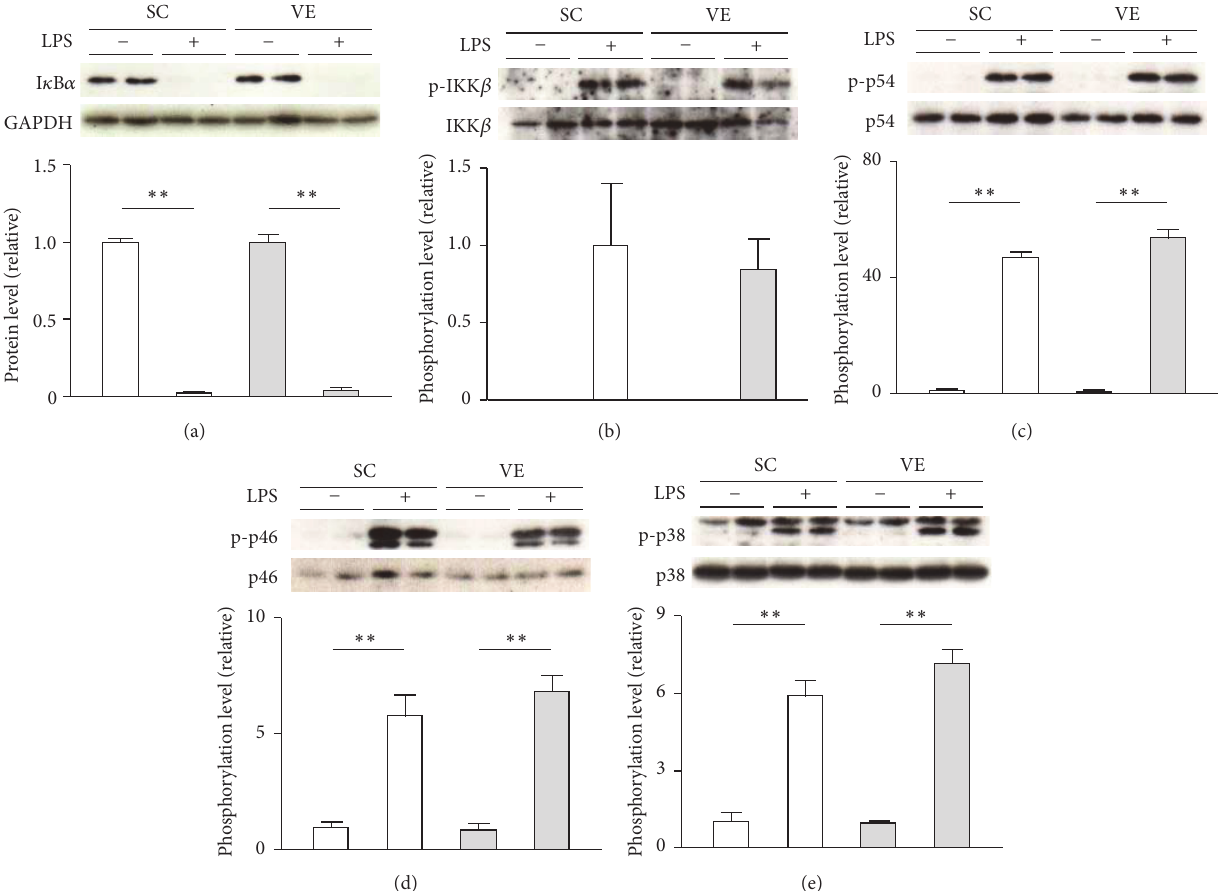
Figure 6: Effects of regular voluntary exercise (VE) on the activation of intracellular signaling downstream of TLR4 in macrophages stimulated with or without lipopolysaccharide (LPS). Peritoneal-exudate macrophages isolated from the sedentary control (SC) and VE mice were cultured for 20 min in the presence or absence of 100 ng/mL LPS. The protein levels of inhibitor of 𝜅 B (I 𝜅 B) 𝛼 (a) and phosphorylation levels of I 𝜅 B kinase (IKK) 𝛽 (b), p54 (c), p46 (d), and p38 (e) were analyzed by western blotting (upper panel). The protein levels are presented as ratios relative to the levels of glyceraldehyde 3-phosphate dehydrogenase (GAPDH) (lower panel), whereas the phosphorylation levels are presented as ratios relative to the respective protein levels (lower panel). Mean ± standard error of the mean (SEM; 𝑛 = 4 ) values are provided. ∗∗ 𝑝 < 0.01 (by one-way analysis of variance [ANOVA] and the Bonferroni